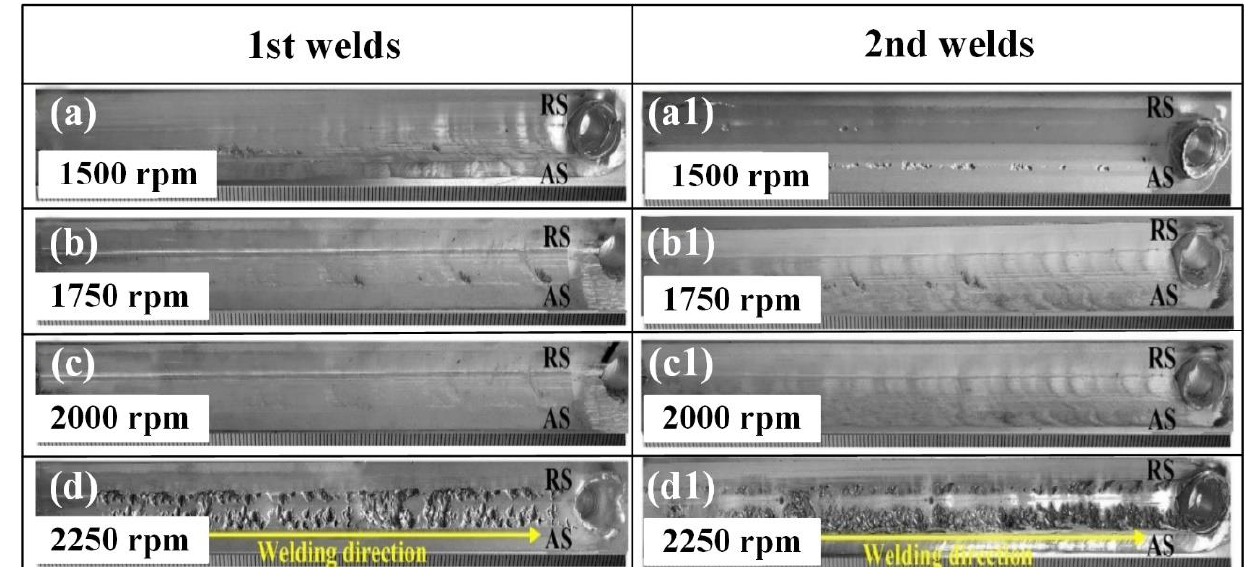
Figure 7. Surface morphologies of the 1st and 2nd welds at different rotation speeds: ( a )–( a1 ) 1500 rpm; ( b )–( b1 ) 1750 rpm; ( c )–( c1 ) 2000 rpm; ( d )–( d1 ) 2250 rpm.